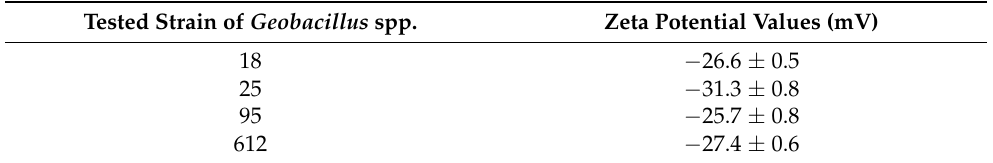
Table 1. Values of the zeta potential (mV) of AgNPs obtained using secretomes of four different Geobacillus spp. strains. Tested Strain of Geobacillus